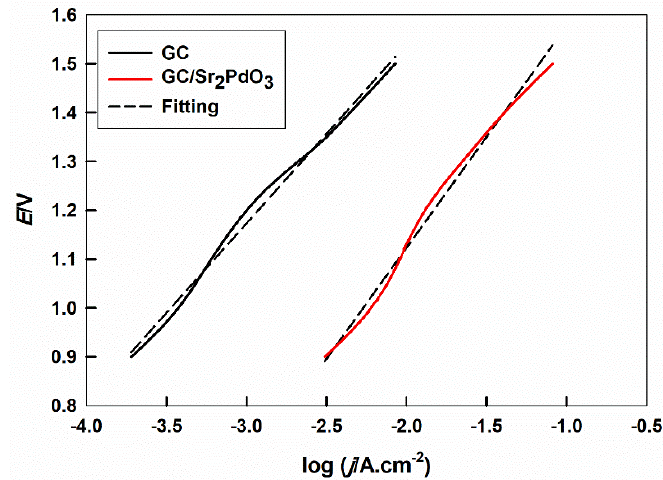
Figure 2. Potentiodynamic polarization of the unmodified and modified GC electrodes with Sr 2 PdO 3 in a 0.1 M HClO 4 solution.